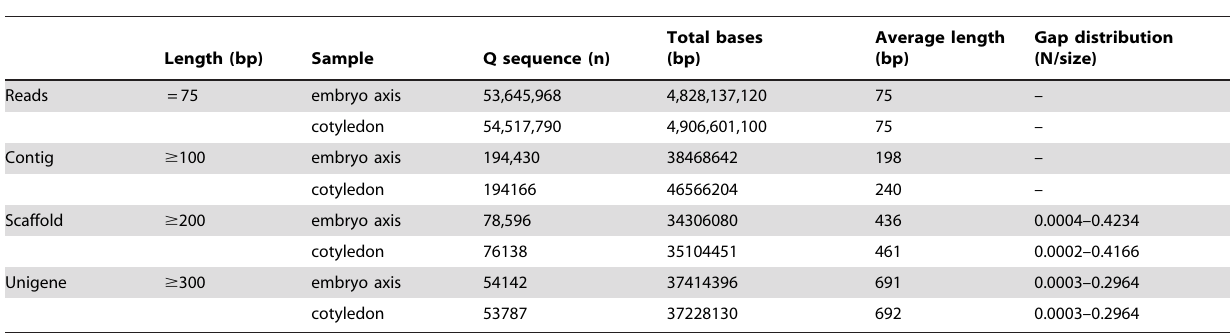
Table 1. The summary of sequencing and assembling